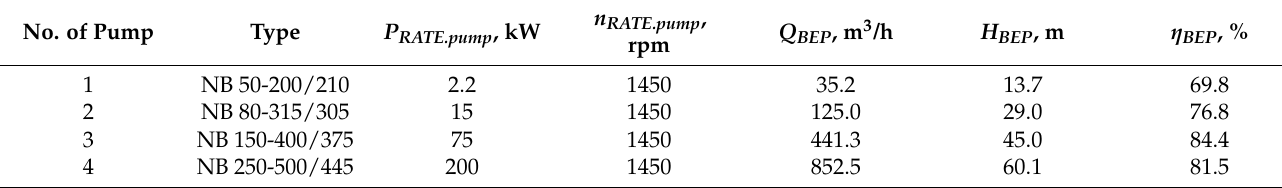
Table 2. Nameplate data of pumps.